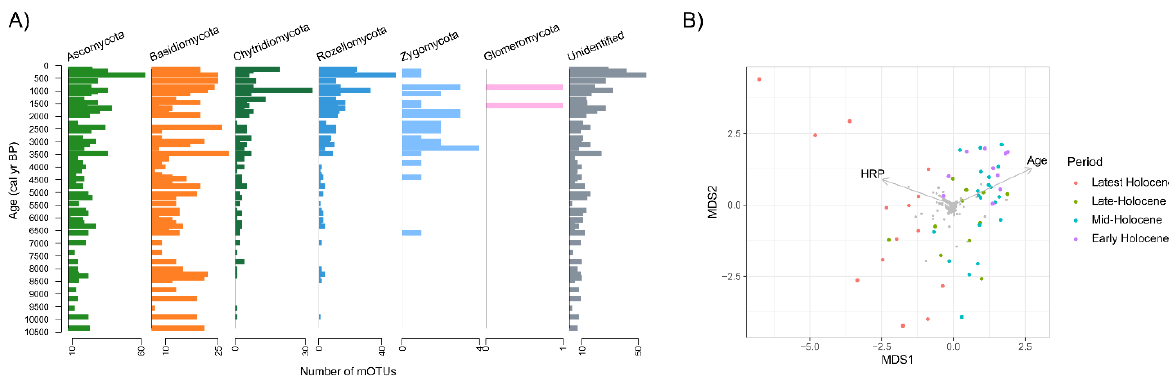
Figure 2. Dynamics of the fungi in the sediment core: ( A ) Richness of observed fungi grouped by phylum; ( B ) Ordination space of PCoA analysis using read abundance (normalized read counts) of mOTUs. Colored points mark various time periods in Holocene and grey points mark the single mOTUs. Arrows indicate linear regression ( envfit in vegan package) of sample age (Age, R 2 = 0.57, p < 0.05) and concentration of human-related pollen (HRP, R 2 = 0.43, p < 0.05) with PCoA space.